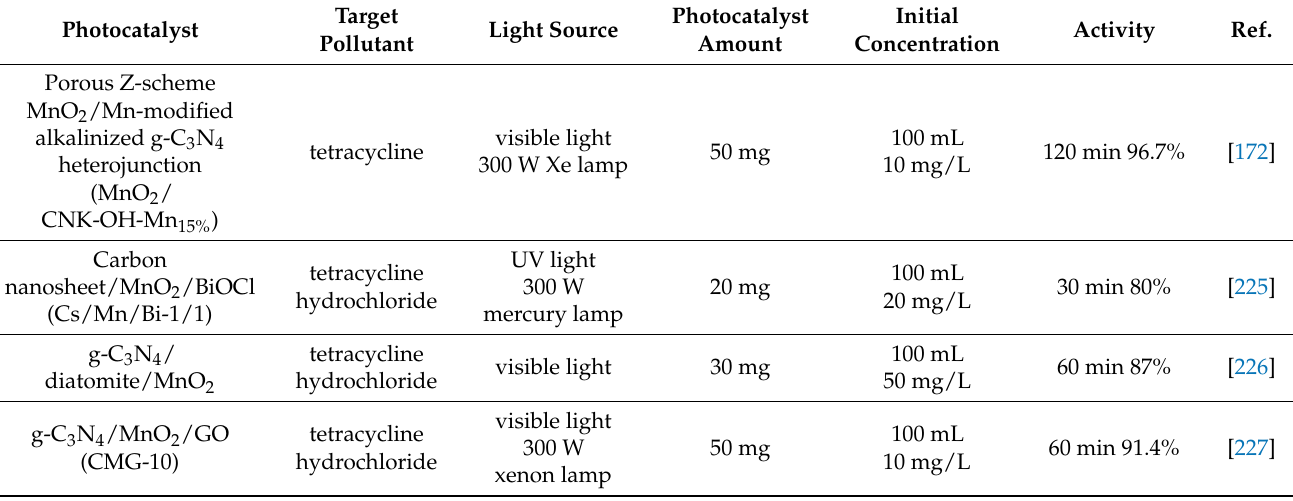
Table 3. Study on MnO 2 -carbon materials for photocatalytic degradation of antibiotic in aqueous